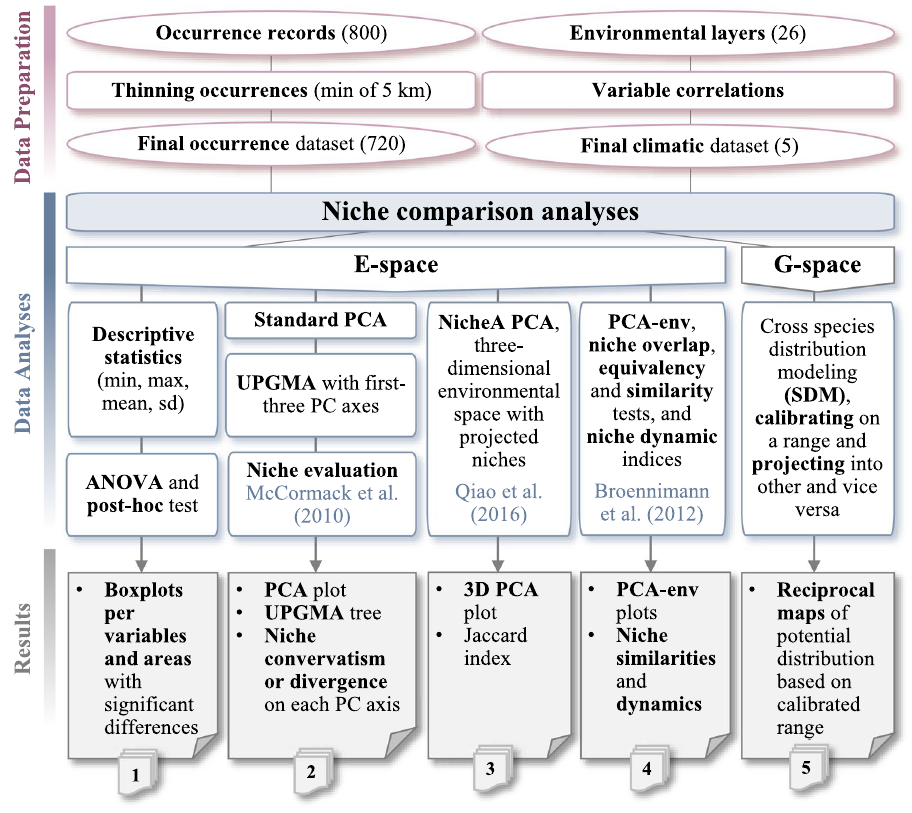
Figure 2. Workflow representation of raw data filtering, niche comparison analyses, and the resulting sets obtained with each methodological approach